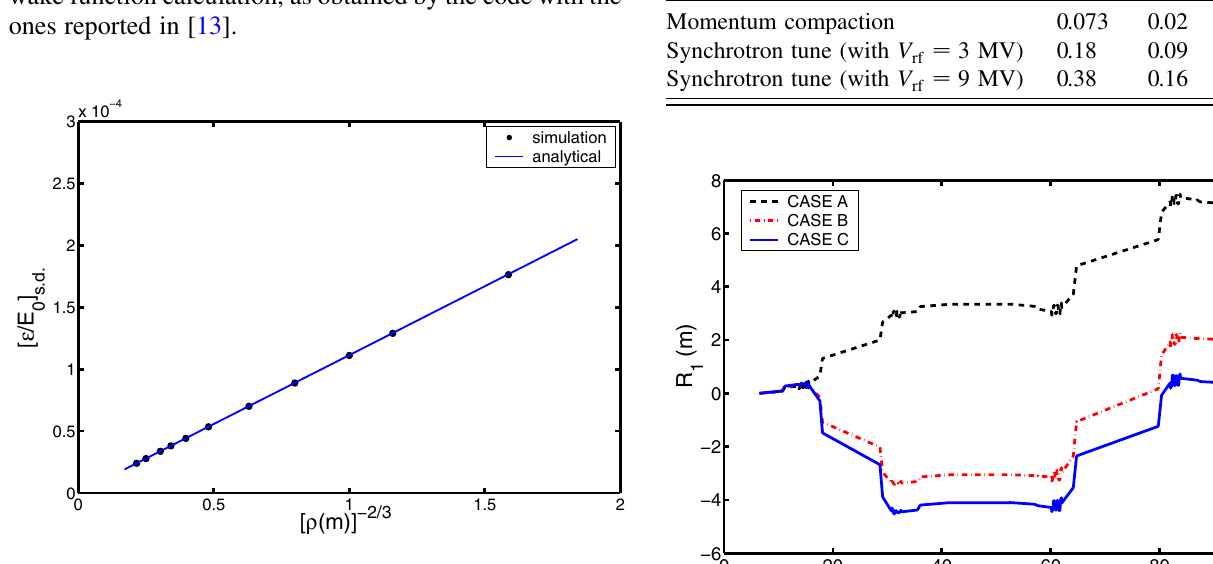
FIG. 4. (Color) Standard deviation of the fractional energy offset as a function of the dipole bending radius in the case of a (cid:3) 0 : 5 mm and Q (cid:3) 1 nC after a dipole Gaussian bunch with (cid:10) L (cid:3) 1 m . with L b